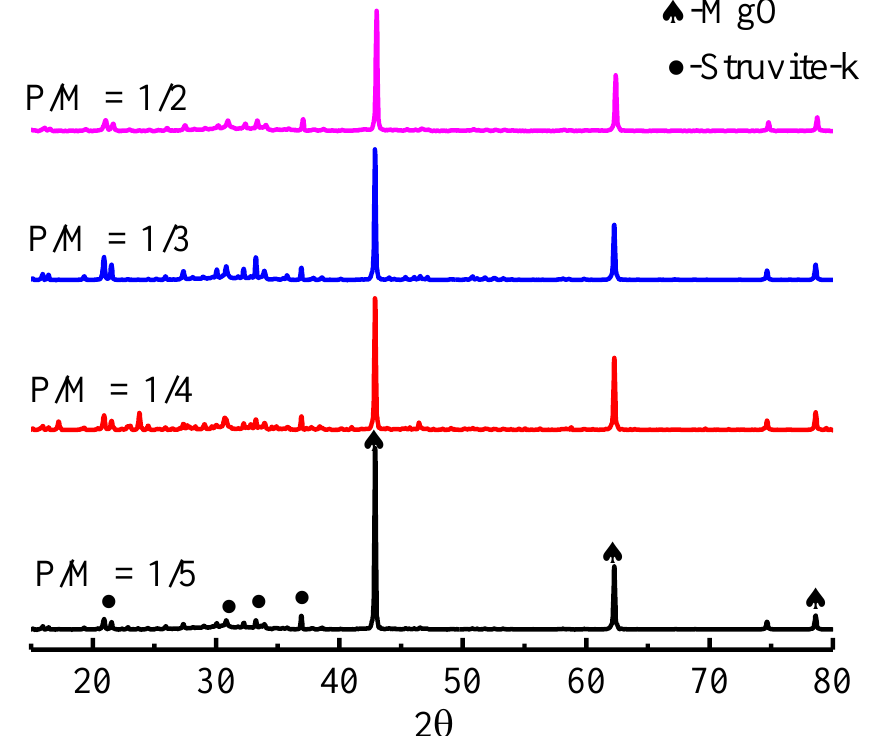
Figure 4. MPC components analysis of different P/M.